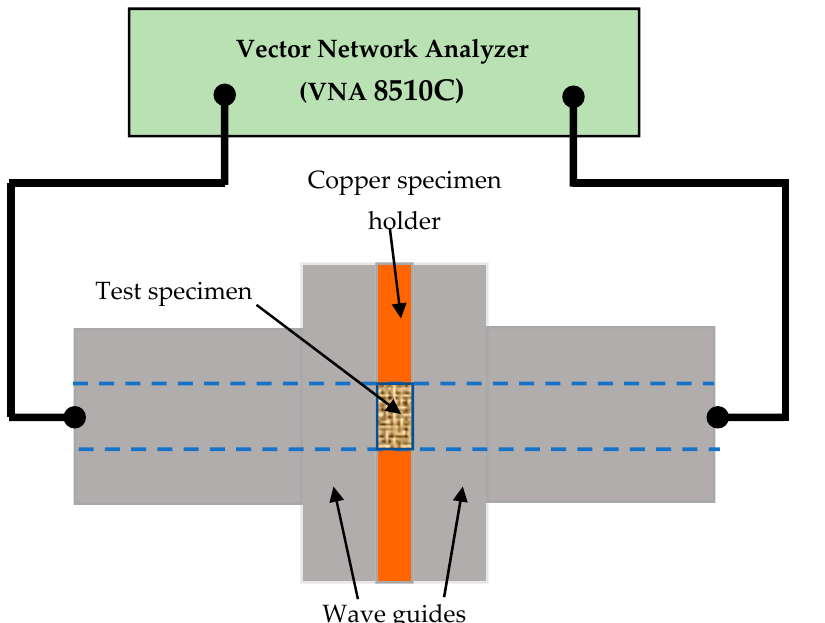
Figure 2. Schematic illustrating the method for measuring electromagnetic wave shielding effec- tiveness.